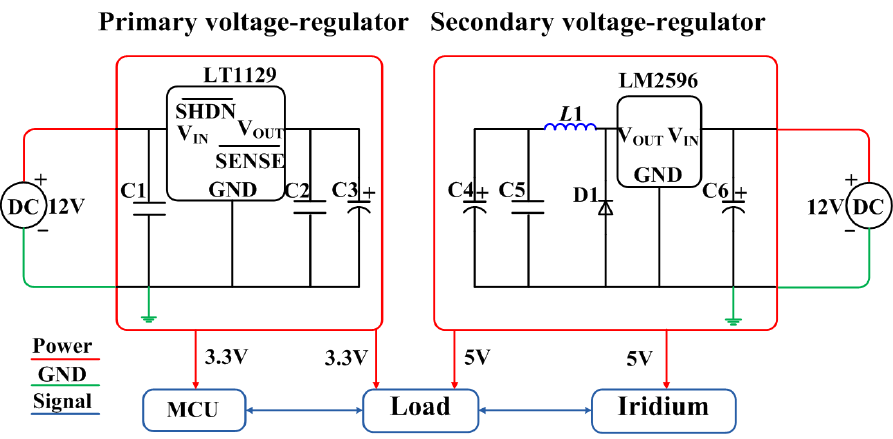
Figure 12. Schematic of the auxiliary circuit.